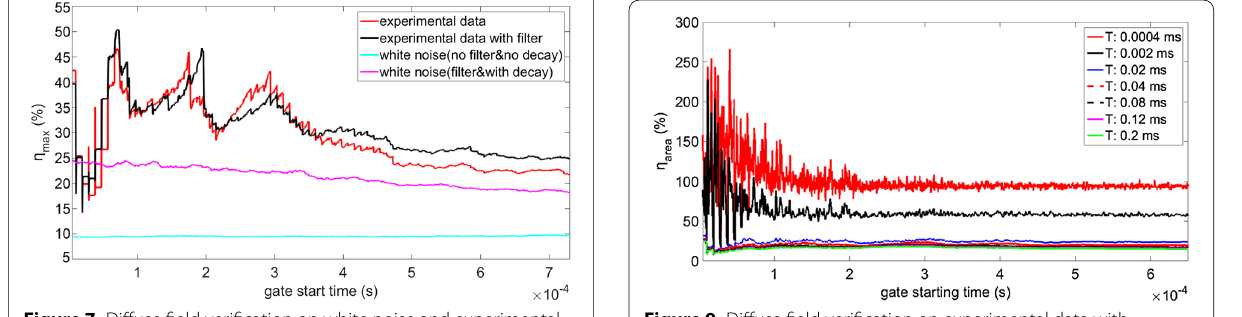
Figure 9 Diffuse field verification on experimental data with different window size using metric η